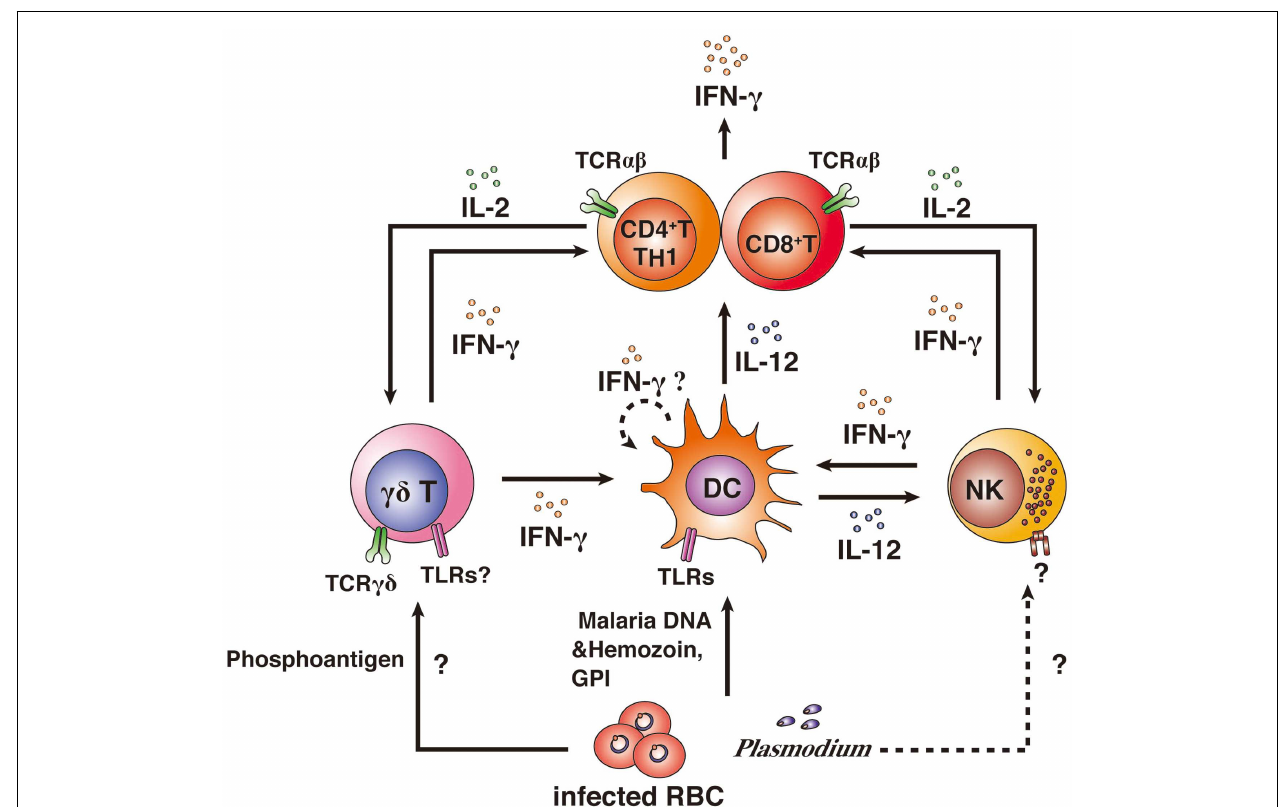
activation of DCs. DCs are thought to have the potential to produce IFN- γ . However, it remains unclear as to whether IFN- γ production from DCs is induced by malarial antigens. Activated DCs produce IL-12 and present antigens to αβ T cells. αβ T cells are strongly activated by IL-12 and antigen presentation. IL-12 also activates NK cells.The malarial antigen-recognition receptor on NK cells remains to be determined. Activation of αβ T cells leads to high IFN- γ production. Furthermore, activated αβ T cells produce IL-2, resulting in the proliferation of γδ T cells and NK cells and the αβ T cells